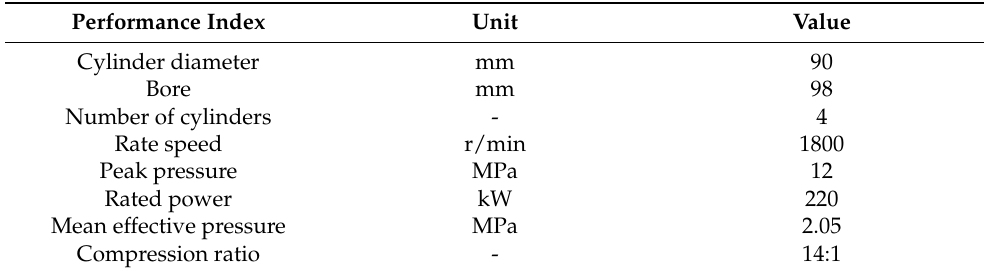
Table 1. Key parameters of the diesel engine.